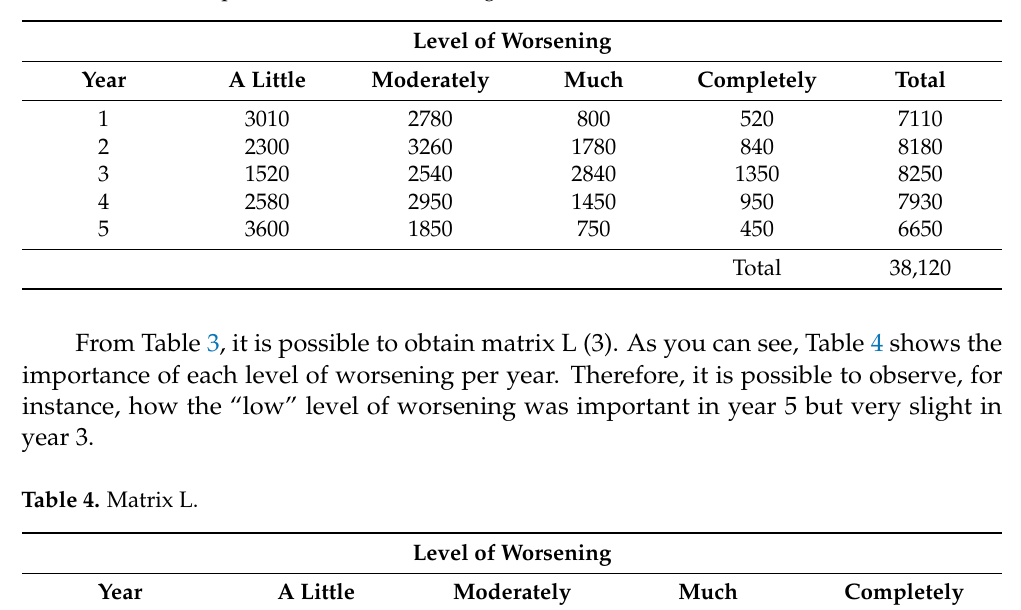
Table 3. Number of patients for each worsening level.